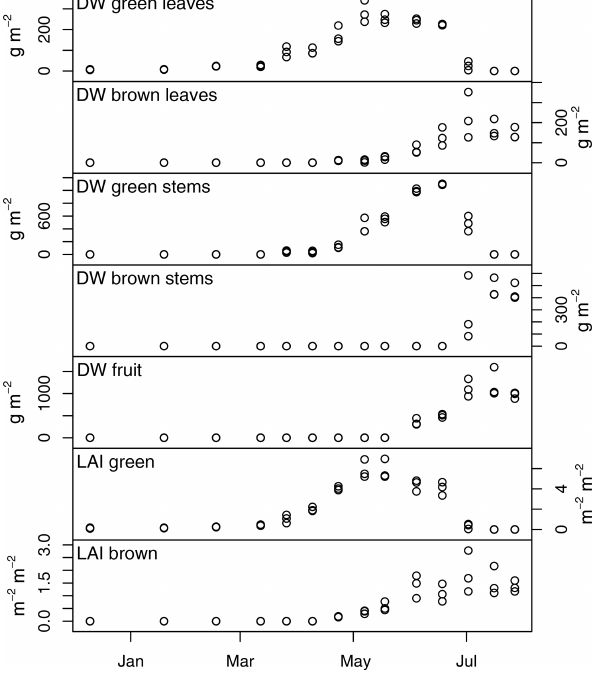
Figure 3. Dry weight (DW) and leaf area index (LAI) of winter wheat on field F08 at the Selhausen site in 2009. Dataset identifier is